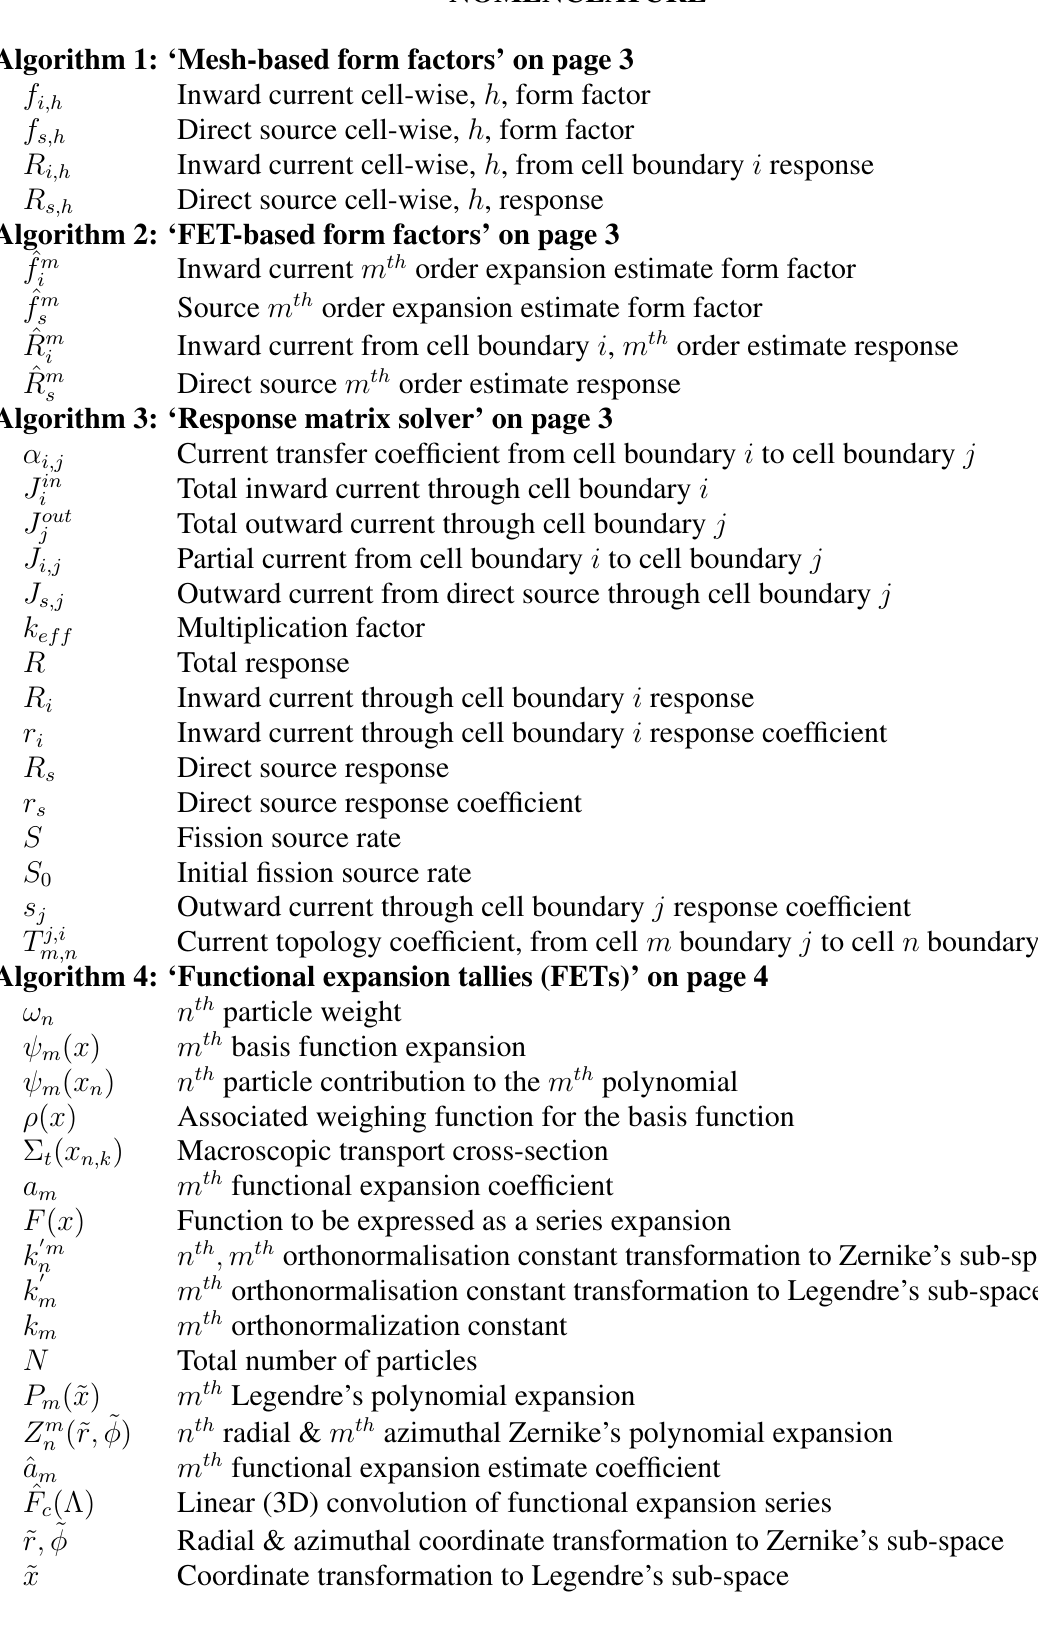
Algorithm 1: ‘Mesh-based form factors’ on page 3